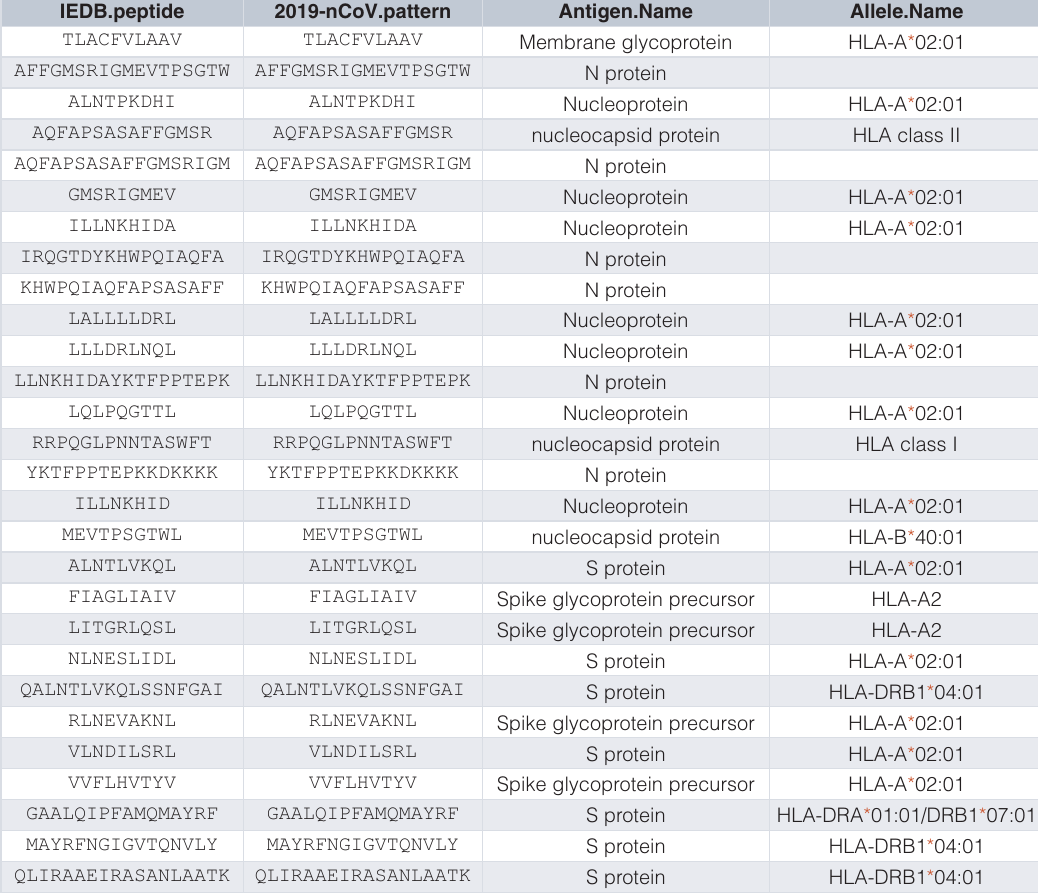
Table 1. 28 2019-nCoV peptides having exact matches with immunogenic SARS-CoV